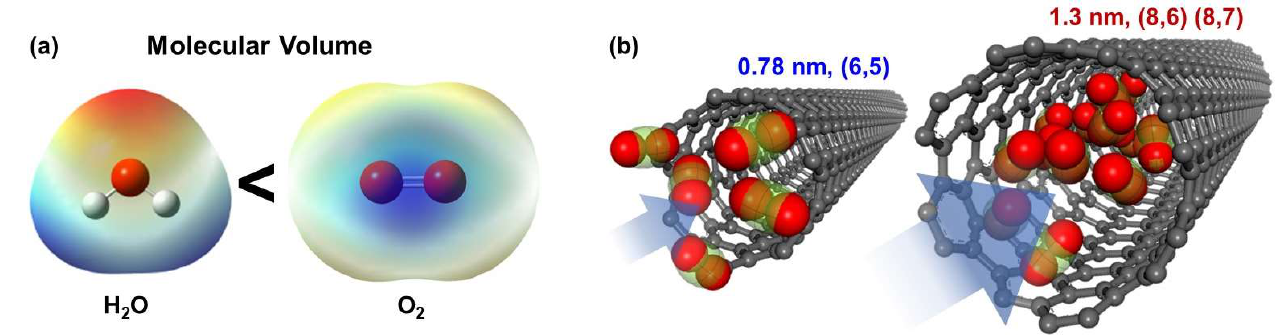
Figure 7. Illustration of the difference in volume between water and oxygen molecules ( a ), and the passage of oxygen inside the SW-CNTs ( b ).